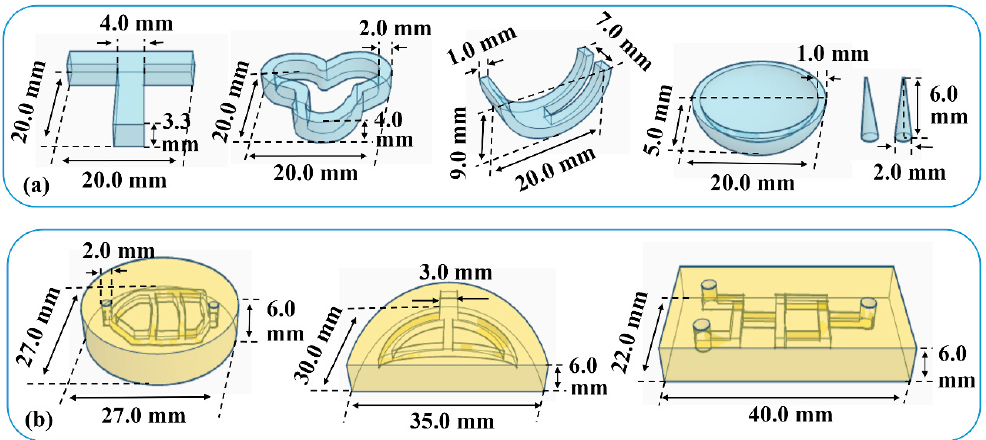
Figure 2. Models of ( a ) various implants and ( b ) physiological channels.